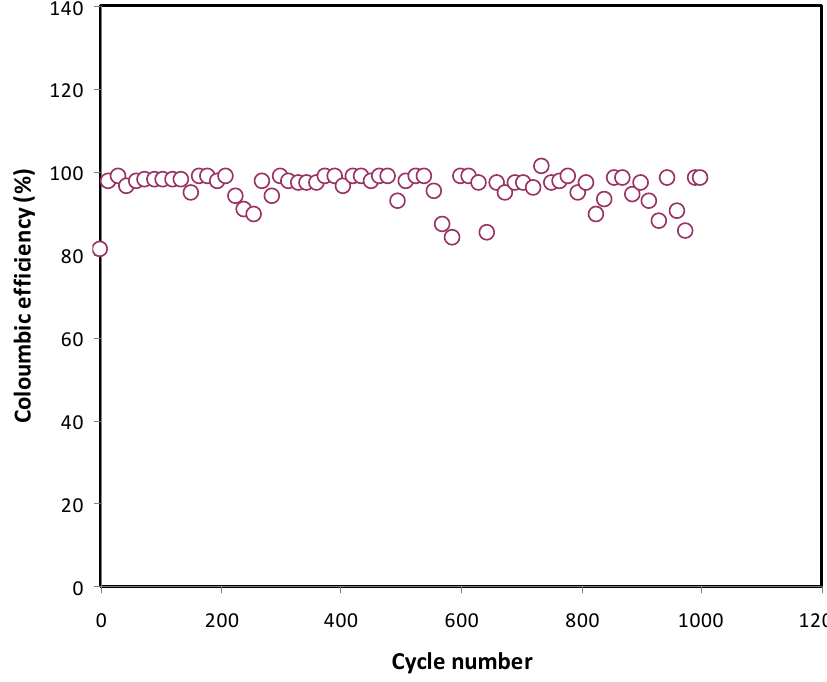
Figure 11. Coulombic efficiency plot over 1000 cycle for the fabricated EDLC.